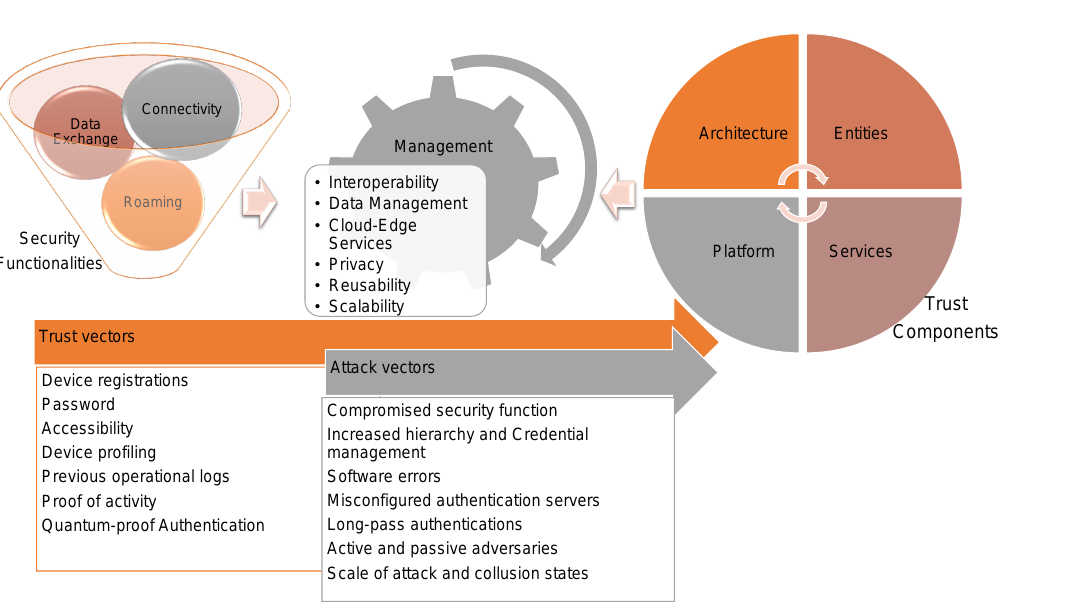
Figure 2. Functional security management with trust and attack